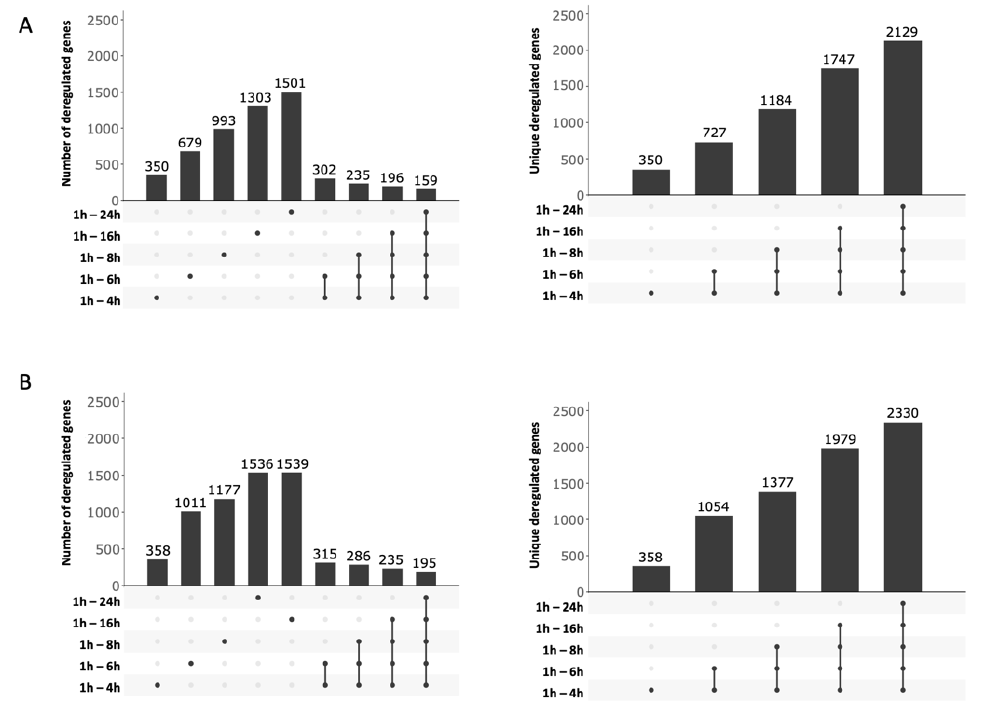
Figure 5. Evolution of deregulated genes from W37 ( A ) and D37 ( B ) strains after the temperature shift. The left panels show the number of differentially expressed genes at each time point (see Table S6) and the number of common genes among indicated time intervals (illustrated by solid black points, linked by black lines). The right panel shows the increasing number of unique genes that are differentially expressed at a minimum of one time point after the temperature shift. Number of deregulated genes (|FC| ≥ 2, p -value ≤ 0.01).